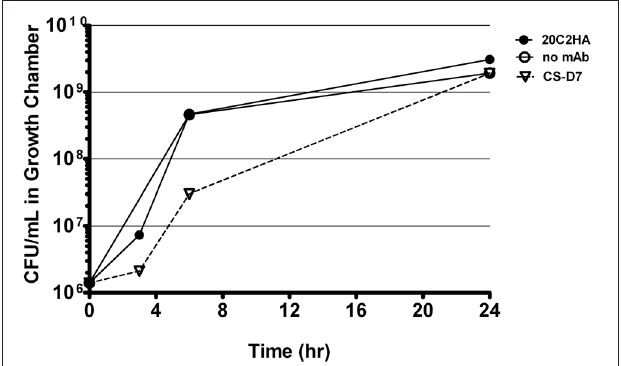
FIGURE 1 | S. aureus growth in the presence of IsdB specific mAb or isotype control mAb. Growth chambers containing 1 × 10 6 CFU Becker and 1mg of mAb CS-D7 (inverted triangle), or 20C2HA, (closed circles), or no mAb (open circles) were evaluated for outgrowth of bacteria during a 24h period. At designated times, a subset of rats were euthanized, chambers removed and bacteria were quantified by serial dilution on